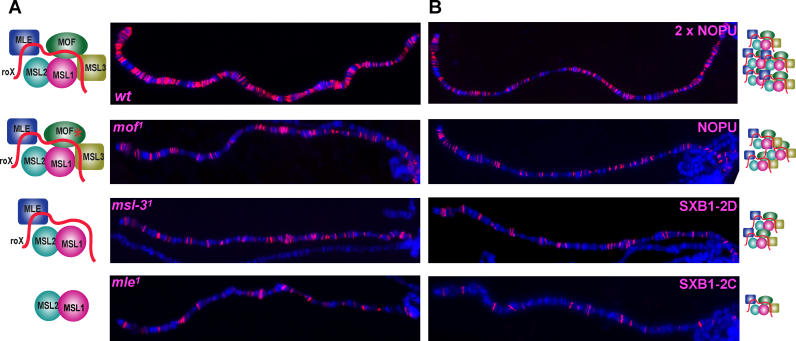
The Drosophila X Chromosome Contains a Hierarchy of DCC Binding SitesPolytene chromosomes from Drosophila larvae showing the DNA stained in blue and anti-MSL1 staining in red.(A) The DCC binds in a defined pattern to the X chromosome in wild-type males (top panel). Mutations in mof, msl-3, and mle lead to partial or non-functioning complexes (cartoons) binding to a subset of sites. Anti-MSL-1 staining of X chromosomes from females expressing MSL2 and homozygous for the mof1, msl-31, and mle1 mutations are shown.(B) The same hierarchy of sites can be seen in females expressing different concentrations of MSL2. The NOPU and SXB1–2 constructs give rise to decreasing levels of MSL2 expression [27], and this leads to the recruitment of the DCC to decreasing numbers of sites on both X chromosomes. These sites are the same as those found in the mutant backgrounds described in (A) [28]. Females homozygous for the NOPU construct (top panel) have a DCC binding pattern quite similar to wild-type males, lacking only a few sites.